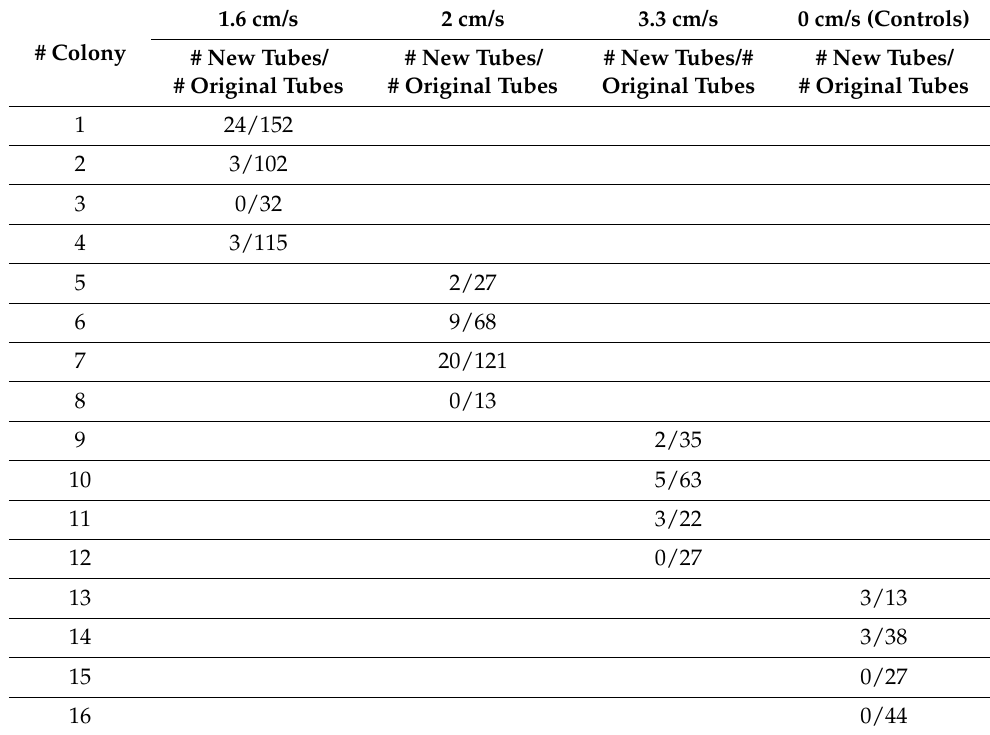
Table 1. Number of new tubes reformed for each colony and flux treatment.